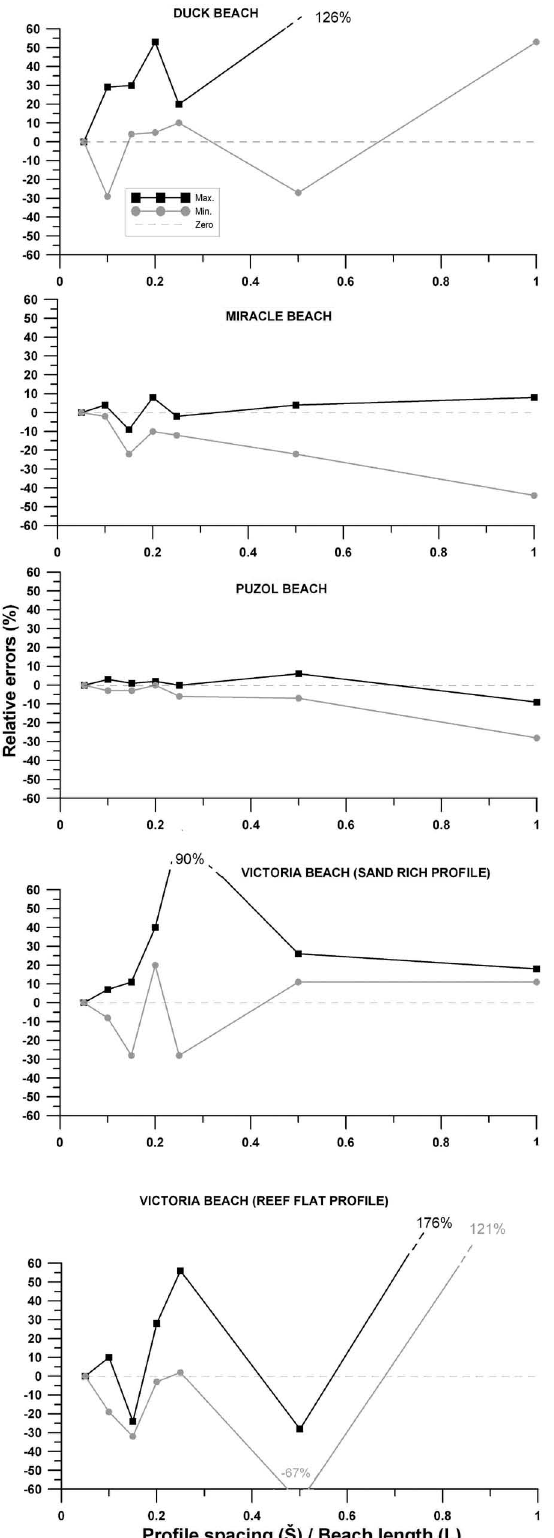
Fig . 6. – Relative error vs. the profile spacing for the different beaches studied. Single profiles correspond to each 1000-m